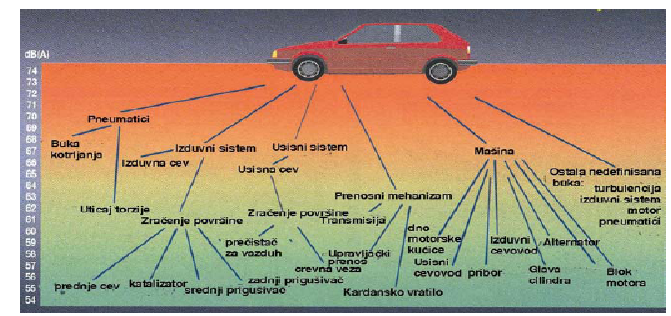
Figure 1 – Generation of noise by car Рис . 1 – Генерирование дорожно - транспортного шума Slika 1 – Generisanje buke koju emituje automobil